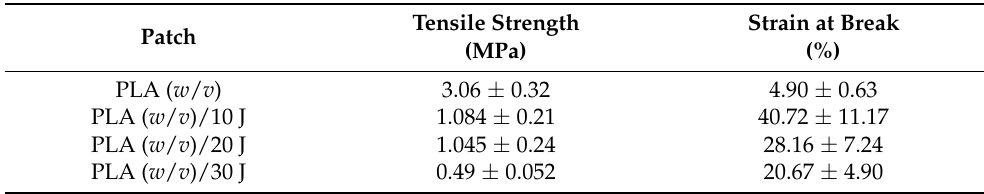
Table 1. Mechanical behaviors of the scaffolds.